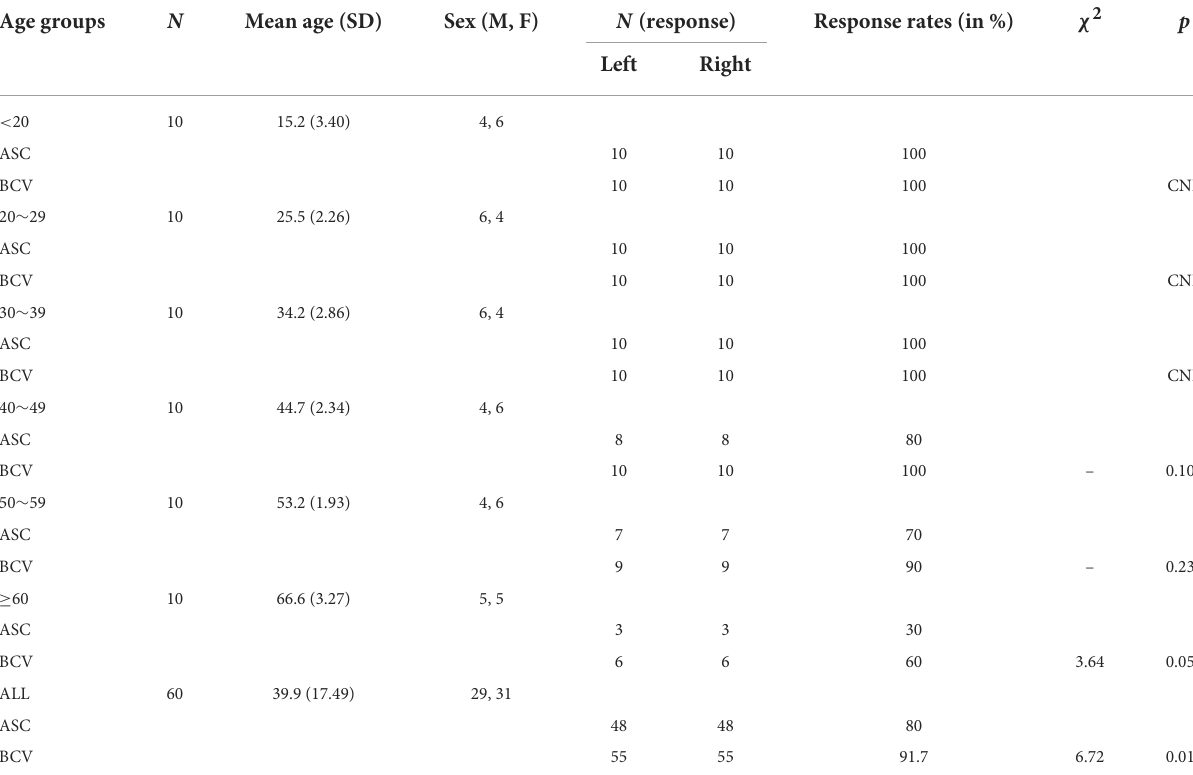
TABLE 2 Demographics and response rates of oVEMP for each stimulus across the age groups. Age groups